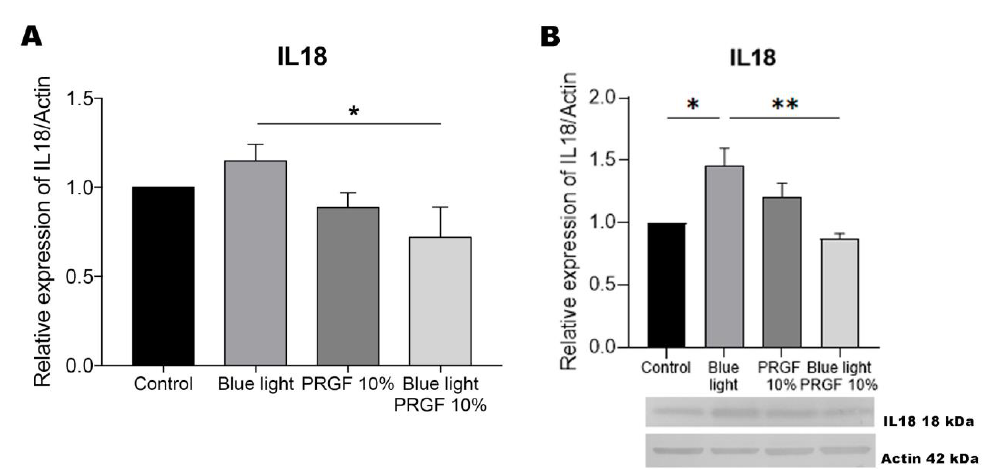
Figure 9. IL18 gene expression, and protein expression relative to the expression of actin. ( A ) IL18 gene expression measured by qPCR. Results indicate that in response to blue light alone the expression of the marker was increased compared to its combination with PRGF. One-way ANOVA, Tukey’s multiple comparison test, * p < 0.05 ( n = 4). ( B ) IL18 protein expression measured by Western blotting. Results indicate that blue light led to a significant increase in the expression of this marker compared to the blue light plus PRGF and control treatments. One-way ANOVA, Tukey’s multiple comparison test, * p < 0.05 and ** p < 0.005 ( n = 4).